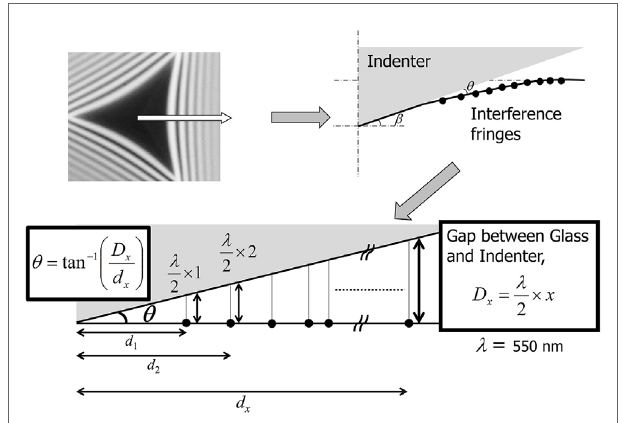
FigUre 5 | schematic procedure for determining the gap angle, θ , the gap distance, D x , between surfaces of indenter and glass . d x , where x is a natural number, is the interval between fringes. The wavelength of light, λ , for imaging is 550